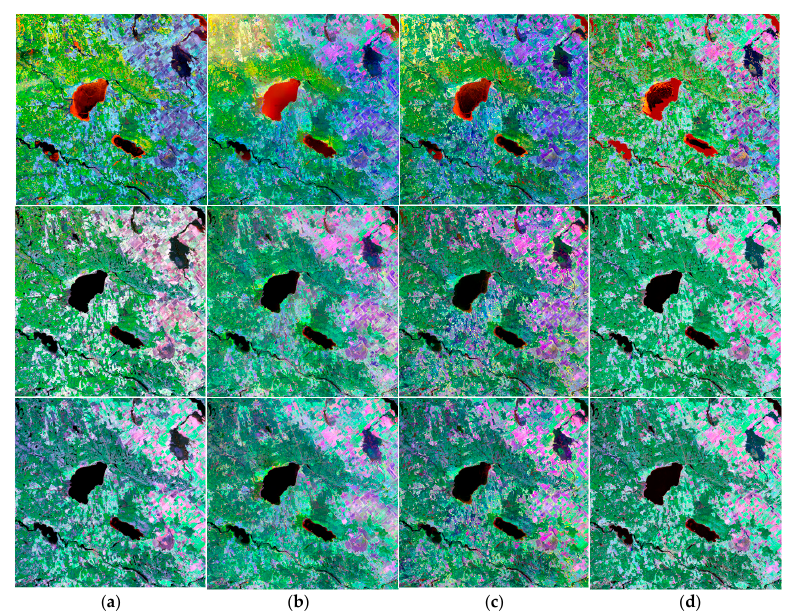
Figure 2. Visual comparison of Landsat-like image series predicted by STARFM, ESTARFM and the proposed PSRFM methods. From the left to the right, Red-NIR-SWIR1 (R-G-B) composites of ( a ) true Landssat-8 OLI images; ( b ) predicted images from STARFM; ( c ) predicted images from ESTARFM; and ( d ) predicted images from PSRFM. From the top to the bottom, the dates of the image time series are 4 April 2016, 20 April 2016 and 6 May 2016.